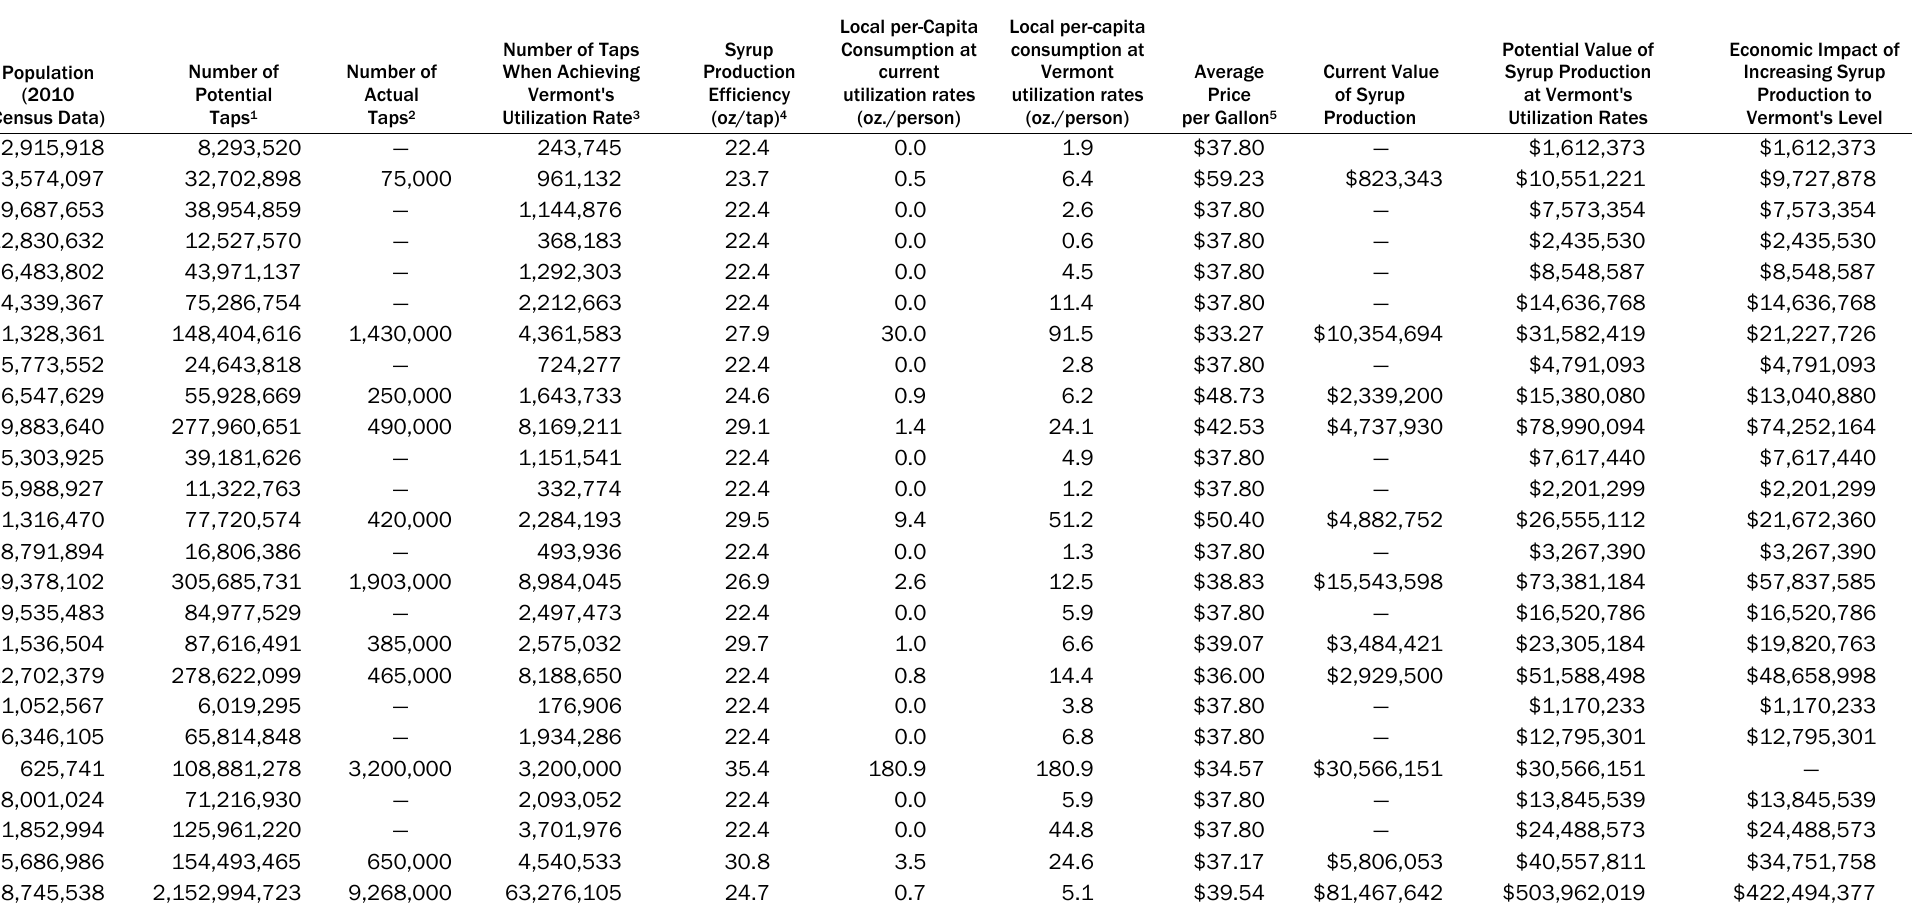
Table 1. The Economic Impact of Increasing Syrup Production Levels to those Achieved in Vermont (all prices in